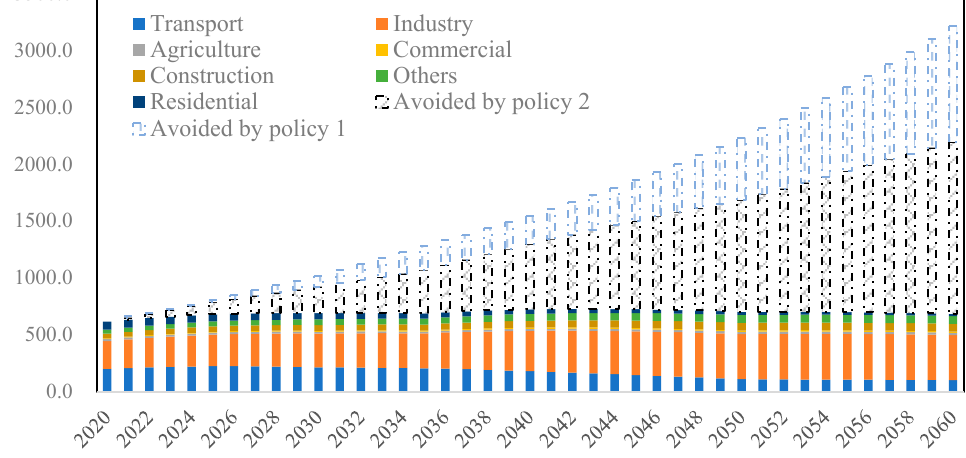
Figure 12. Demand under carbon peaking policies and differences relative to sub-scenarios 1 and 2.